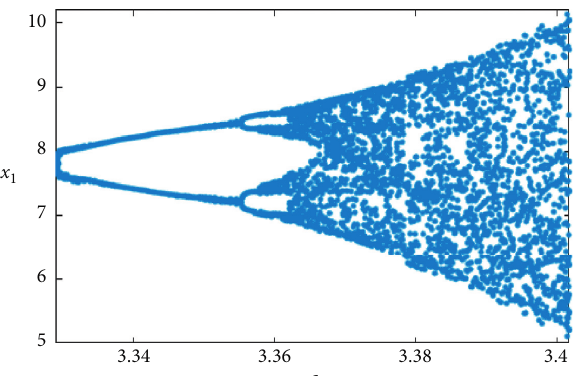
Figure 7: Bifurcation diagram of 3D jerk system (1) with pa- rameters b � 1 and c �